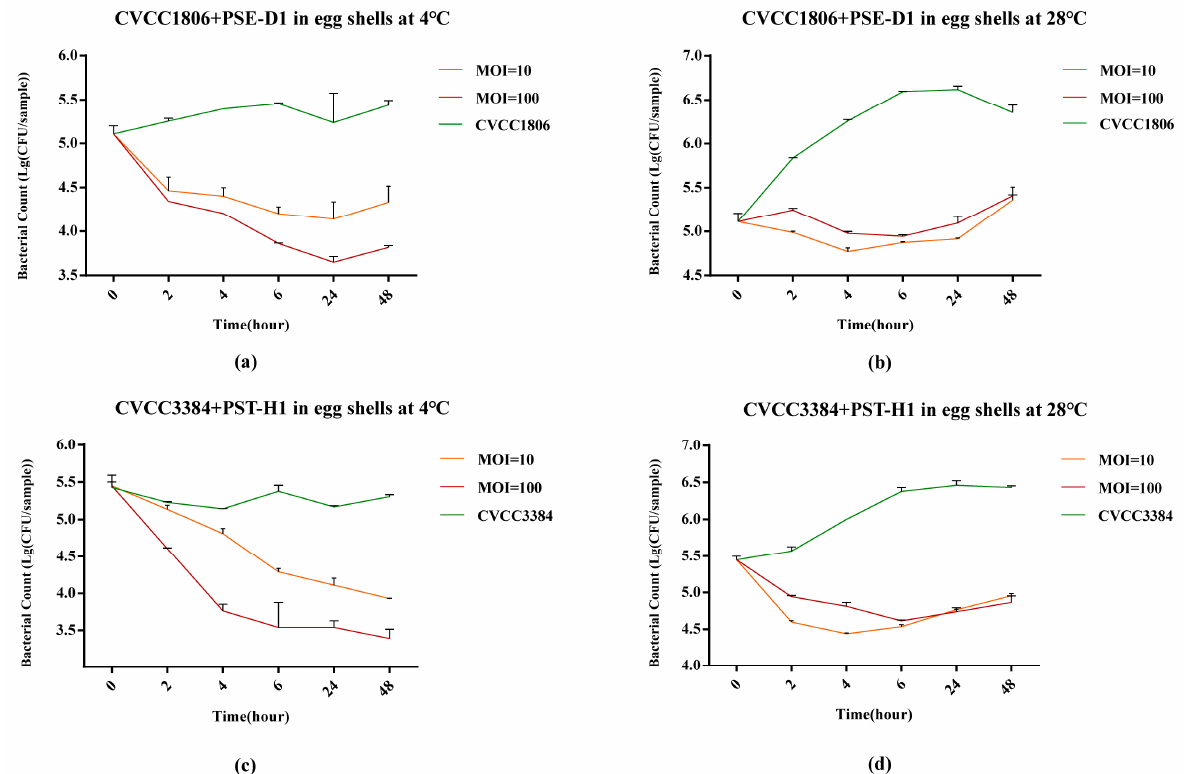
Figure 8. Determination of the antibacterial effect of phages in eggshells at different temperatures. ( a ) CVCC1806+PSE-D1 in eggshells at 4 °C. ( b ) CVCC1806+PSE-D1 in eggshells at 28 °C. ( c ) CVCC3384+PST-H1 in eggshells at 4 °C. ( d ) CVCC3384+PST-H1 in eggshells at 28 °C.